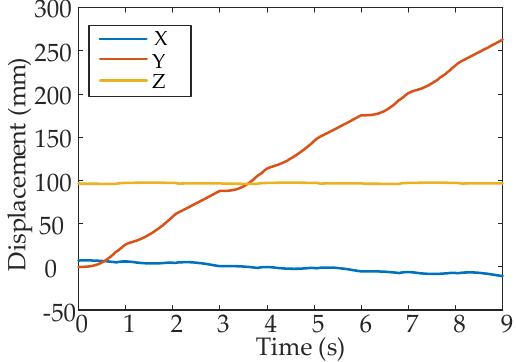
Figure 16. Vertical view of one period simulation sequence with leg 1 fault.